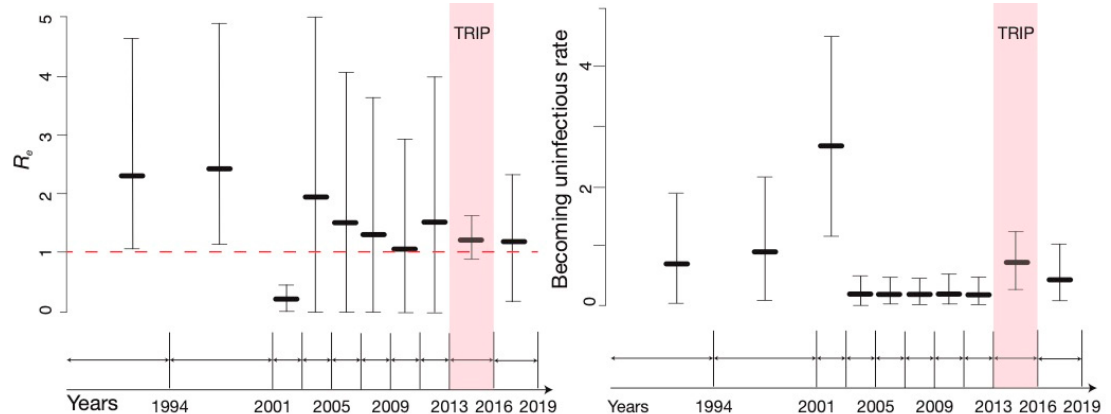
Figure 4. Temporal estimates of the effective reproductive number, R e , and the becoming uninfectious rate, obtained from Odessa datasets after removal of all sequences generated by network-based recruitment of TRIP participants. The red dotted line represents the epidemiological threshold of R e =1.